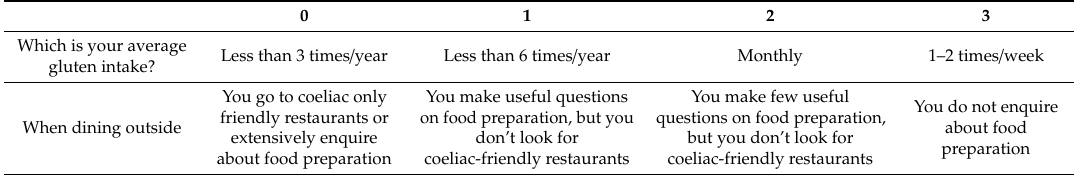
Table 1. Questionnaire for the assessment of adherence to gluten-free diet (GFD) in paediatric